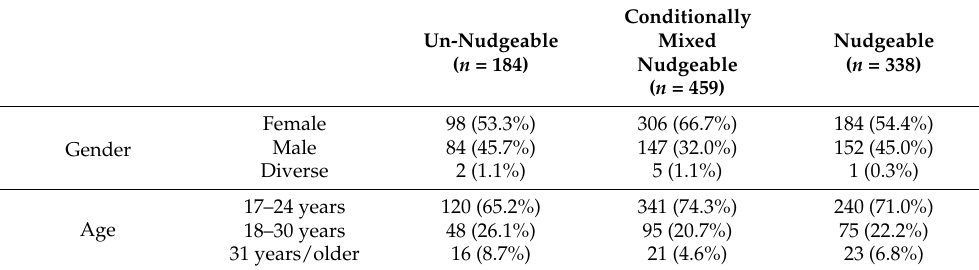
Table 6. Demographic information on the clusters.